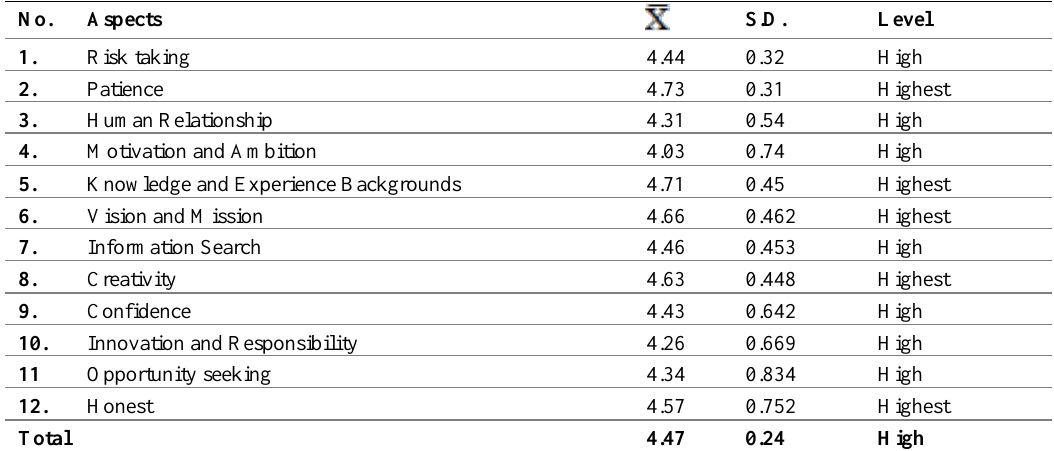
Table 4: Mean ( ) and Standard Deviation (S.D.) of desired characteristics of successful start-up entrepreneurs in Prachuap Kirikhan province in Overall